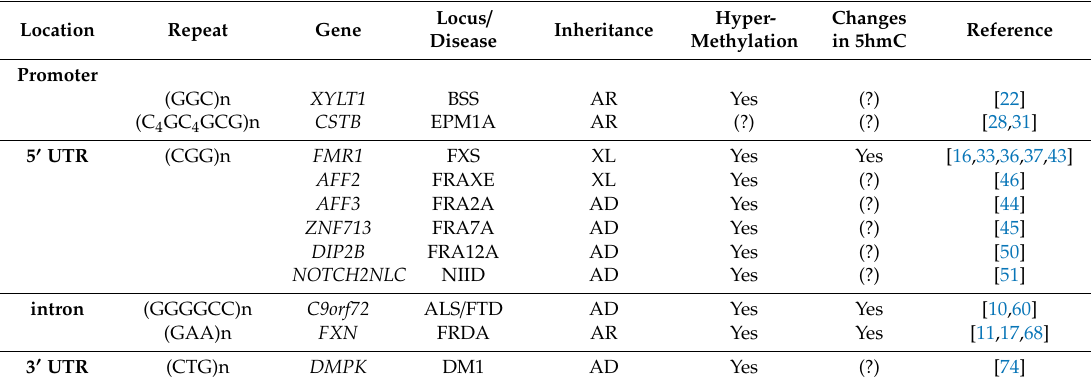
Table 1. Unstable disease repeats and